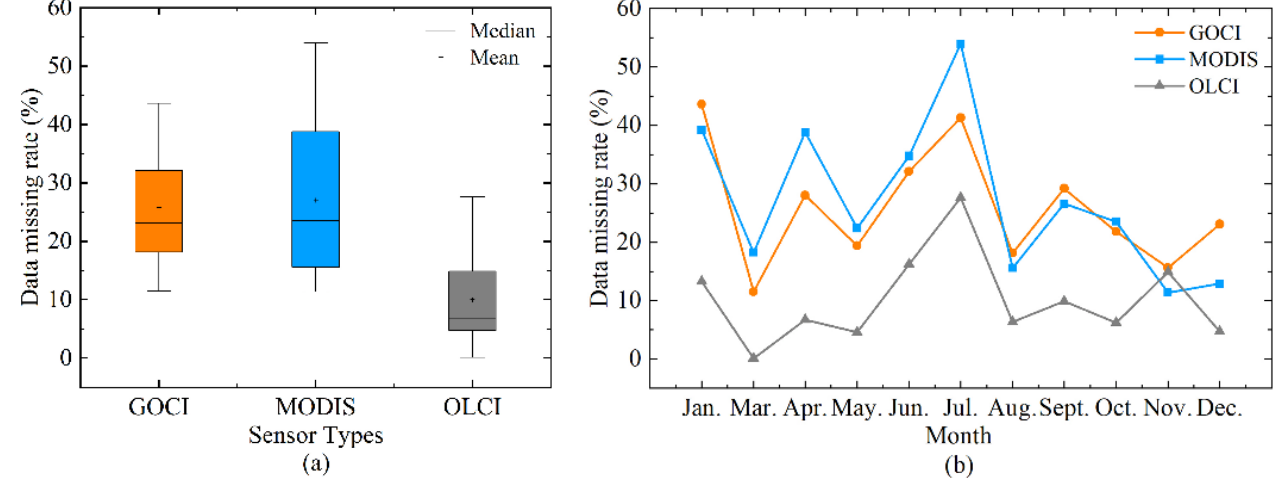
As shown in Table 5 and Figure 9, the missing rate of GOCI is mainly in the range of 15% to 30%, whereas that of MODIS is mainly in the range of 15% to 35%, with a large variation in missing rate per month. The missing rate of OLCI is mainly in the range of 4% to 15%, with less variation in the size of the missing rate per month. Its information is more complete and robust than those of GOCI and MODIS. Interestingly, the missing rates of the three products for January, June and July are larger than in the other months. MODIS products even lost half of their information in July. In addition, not only are the trends of the missing rates similar among the three products, but the monthly magnitudes of the missing rates of GOCI and MODIS are similar.